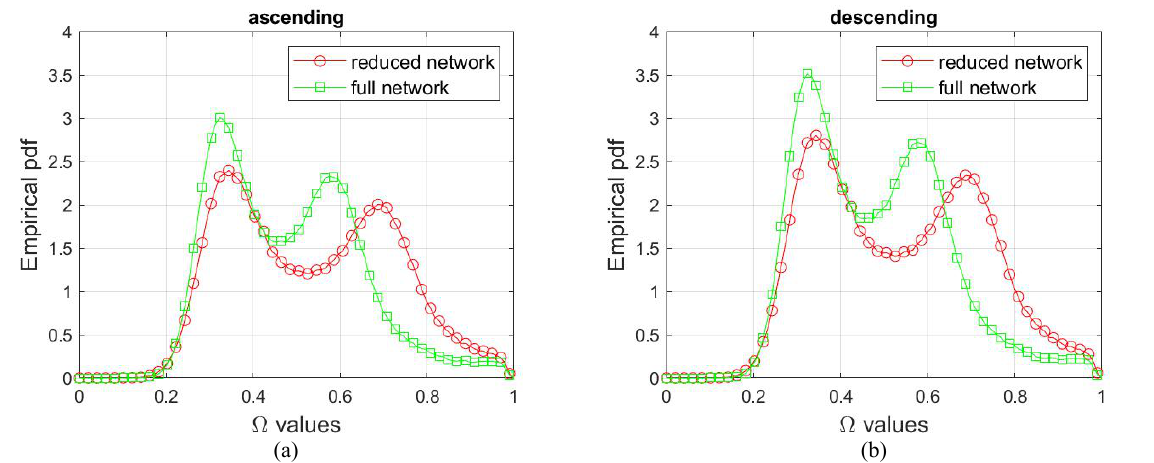
Figure 3 . Histogram of the equivalent temporal coherence values computed over the whole area of interest, comparing full(green) and reduced (red) interferogram network. Sentinel-1 ascending (a) and descending (b) data.